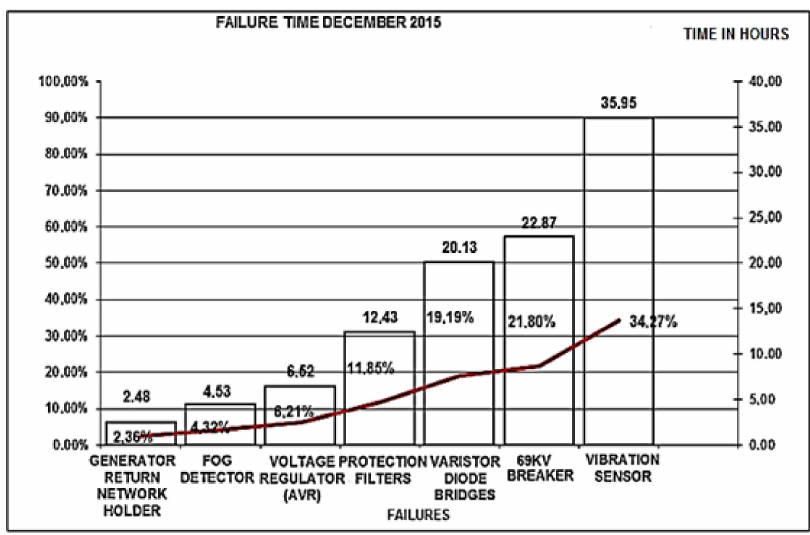
Figure 11. Failure Time results indicators, December